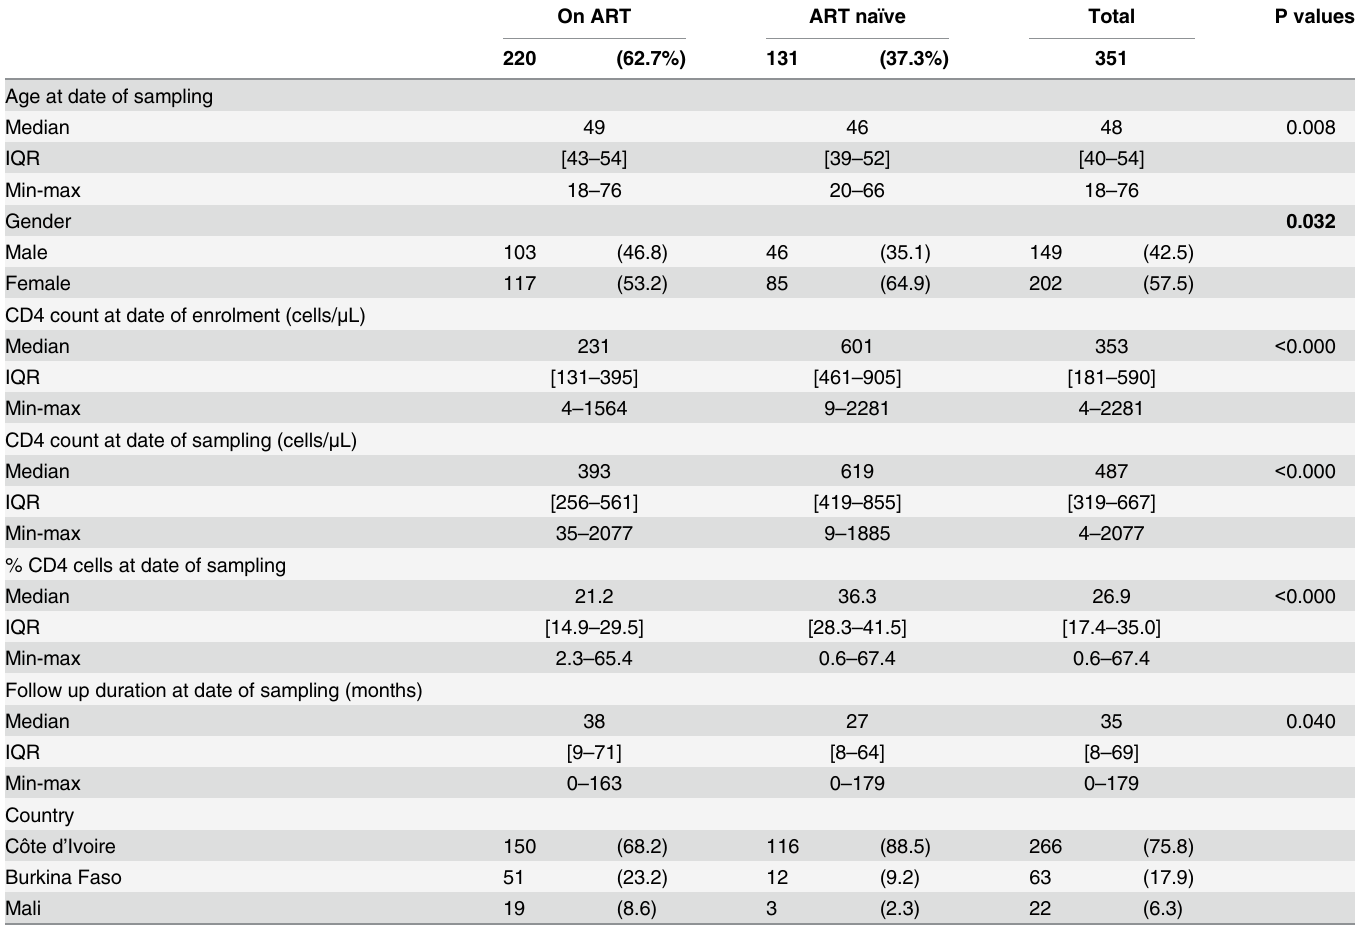
Table 1. Demographic and follow-up characteristics of HIV-2 infected patients in the IeDEA-WA HIV-2 cohort.